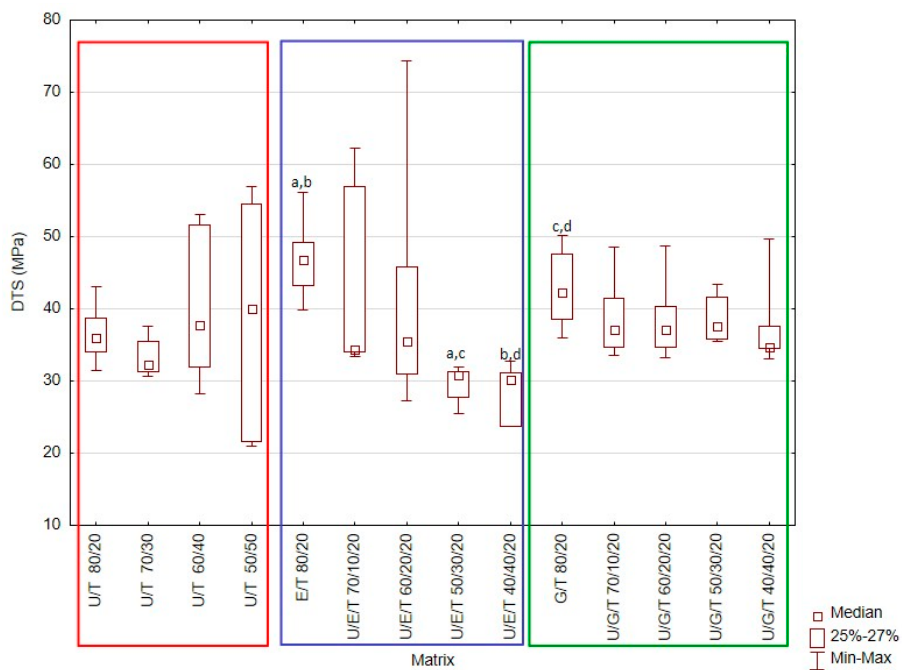
Figure 3. Box-and-whisker plot of diametral tensile strength (DTS). For variables with the same letter (a–d), the difference is statistically significant ( p ≤